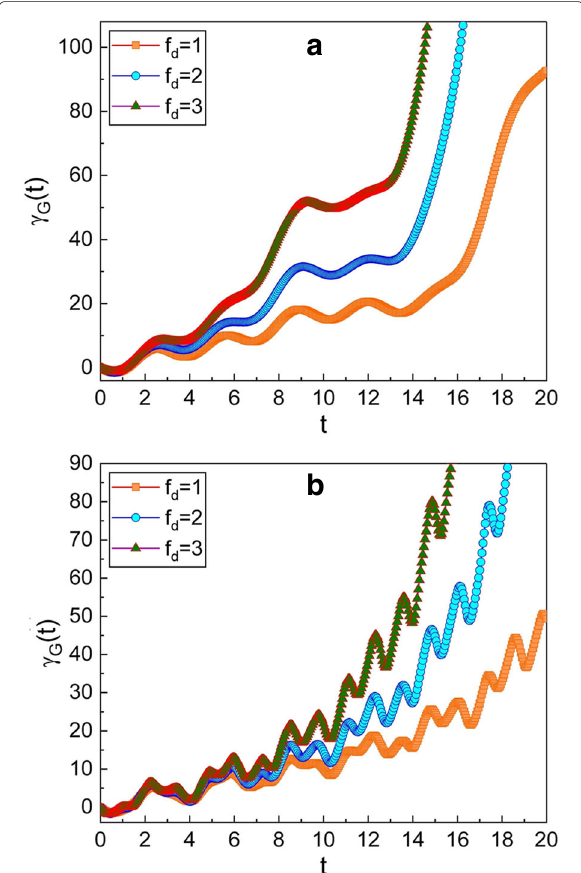
Fig. 4 Time evolution of the geometric phase for several different values of f d . The value of ω used in the graphics is 0.3 for a and 5 for b . √ 2, ν = 1, m = 1, ω 0 = 1, γ = 0.3, A 0 = 1, We have used μ = ( 0 ) = 0. As the amplitude ( f (cid:2) = 1, ϕ = 0, and γ G d ) of the